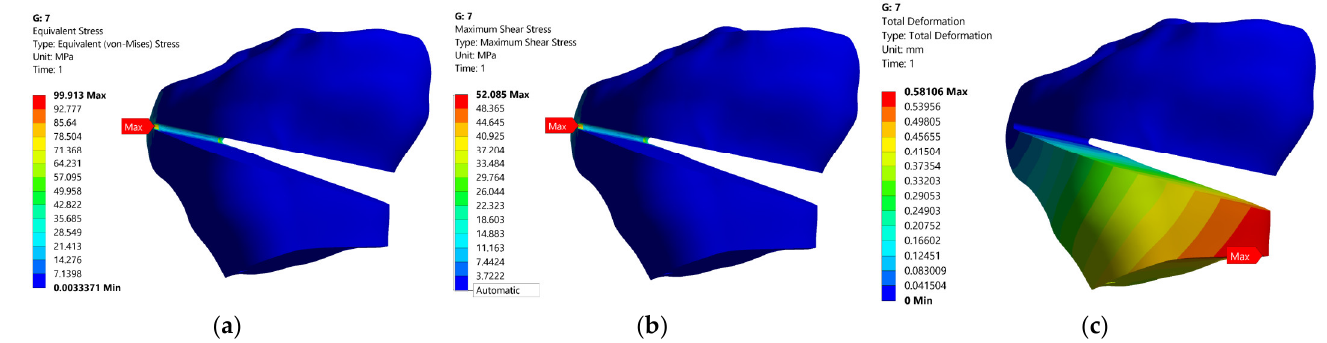
Figure 12. Static FEM analysis for model with code 7: ( a )—equivalent stress, ( b )—shear stress, ( c )—displacement. Table 4. Regression equations for: equivalent stress, shear stress, displacement.